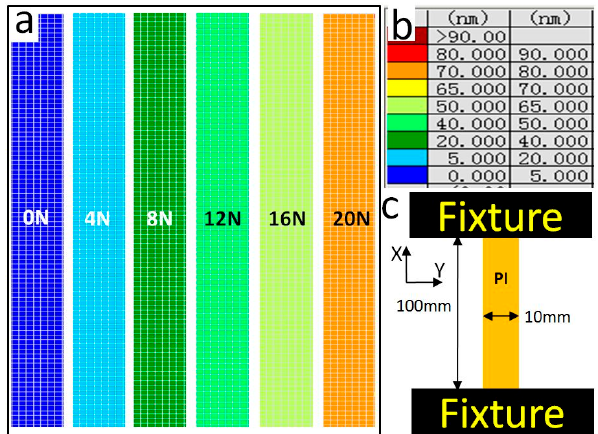
Figure 4. Distribution of uniaxially stretched PI membrane sample under different values of tensile force. Values of tensile force are 0, 4, 8, 12, 16, and 20 N ( a ). Different colors correspond to different retardation value ranges ( b ). Schematic of uniaxially stretched PI membrane with 100 mm length, 10 mm width, and 25 μ m thickness ( c ).